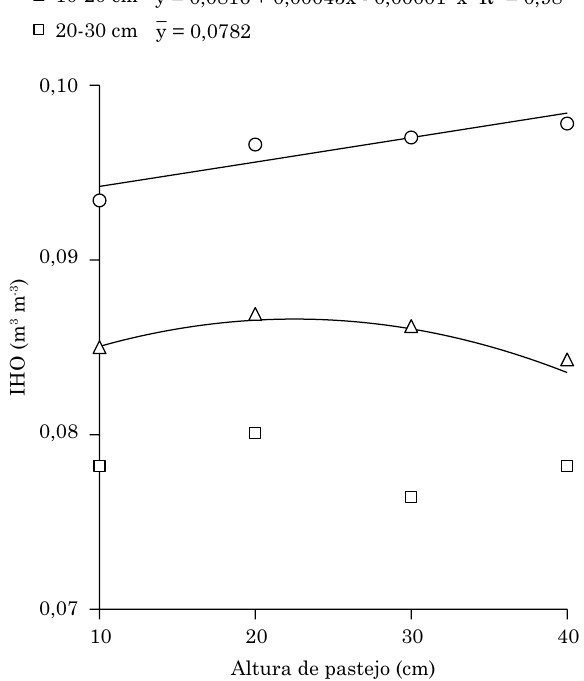
Figura 4. Intervalo hídrico ótimo (IHO) em função de quatro altura de pastejo (10, 20, 30 e 40 cm) em três camadas de solo e sem pastejo (SP). º: coeficientes de regressões linear e quadrática significativos a 10 % pelo teste